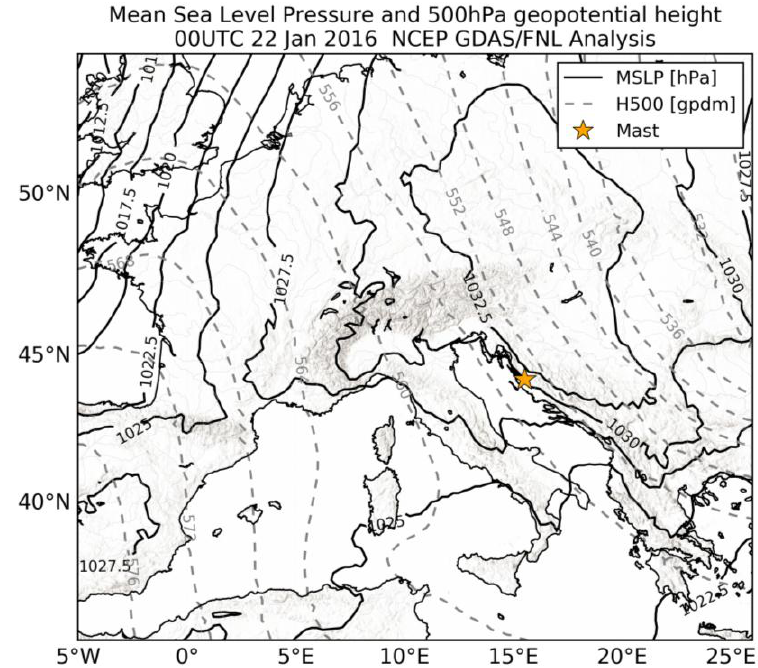
Figure 9. As with Figure 3, but for B13 (SA); 00 UTC on 22 January 2016.